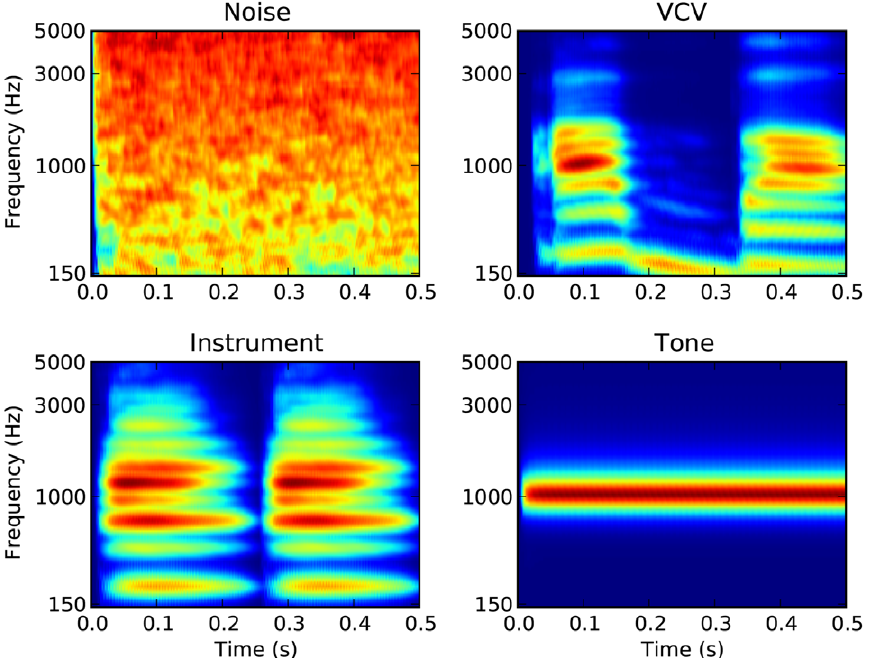
Figure 4. Cochleograms of test sounds used in simulations: white noise; vowel-consonant-vowel (VCV); instruments; pure tones (between 150 Hz and 5 kHz, uniformly distributed in ERB scale). The cochleograms show the output of the gammatone filters used in the model, half-wave rectified and low-pass filtered [56].